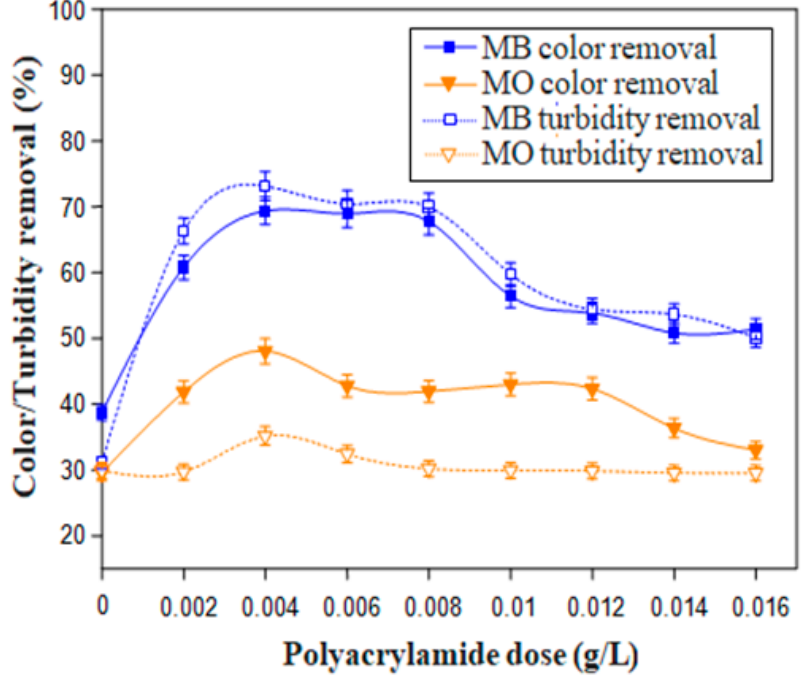
Figure 7. Flocculation performance of the chemical flocculant (polyacrylamide) (Dyes concentration = 0.10 g/L, coagulant dose = 0.30 g/L).